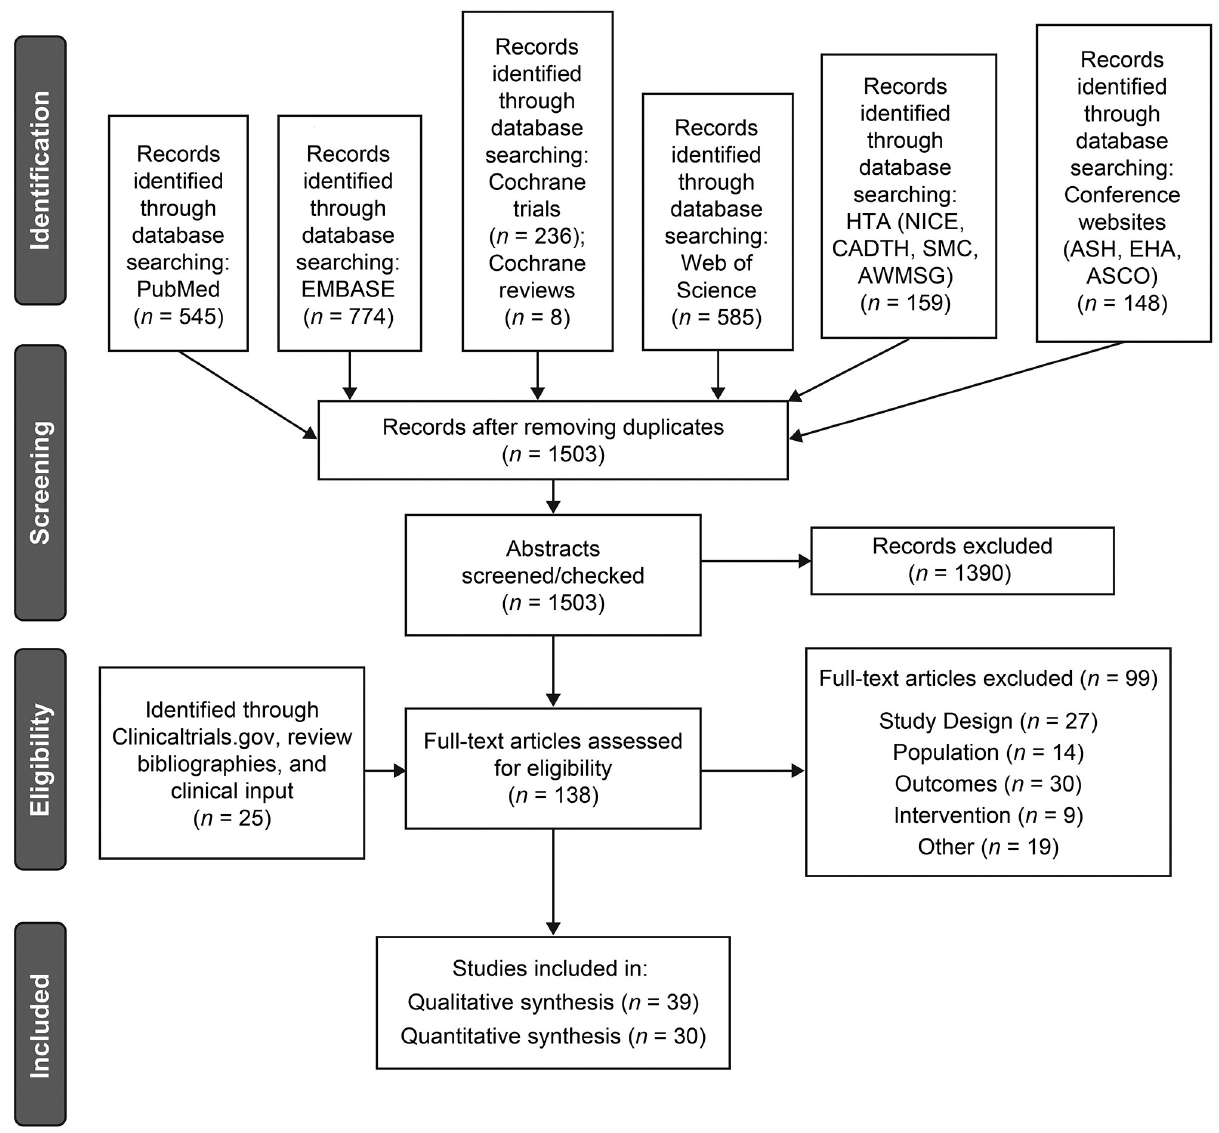
Fig 1. PRISMA diagram. English-language reports of studies of thrombopoietic agents identified from Cochrane Central Register of Controlled Trials, Cochrane Database of Systematic Reviews, PubMed, Embase, ClinicalTrials.gov, HTAs, a hand search of bibliographies, and clinical input were assessed for eligibility in a two-part process per a prespecified protocol to identify relevant articles for analysis. ASCO, American Society of Clinical Oncology; ASH, American Society of Hematology; AWMSG, All Wales Medicines Strategy Group; CADTH, Canadian Agency for Drugs and Technologies in Health; HTA, health technology assessment; NICE, National Institute for Health and Care Excellence; SMC, Scottish Medicines Consortium; thrombopoietic agent, thrombopoietin receptor